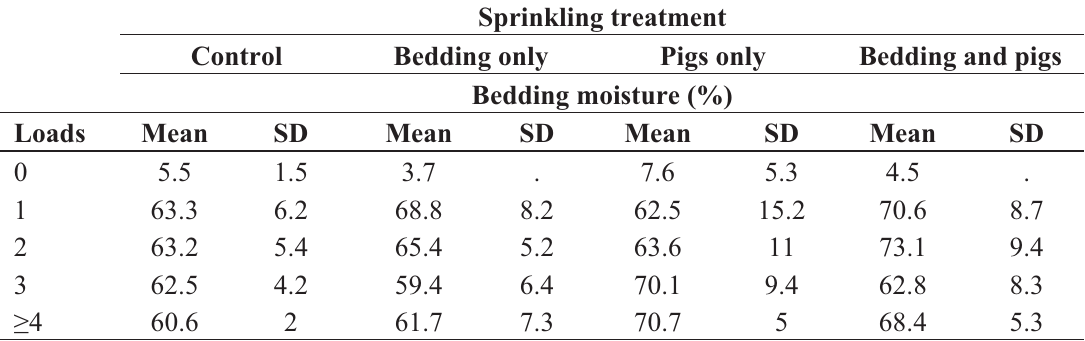
Table 2. Experiment 1. Bedding moisture 1 by sprinkling method 2 combined WARM 3 and HOT 4